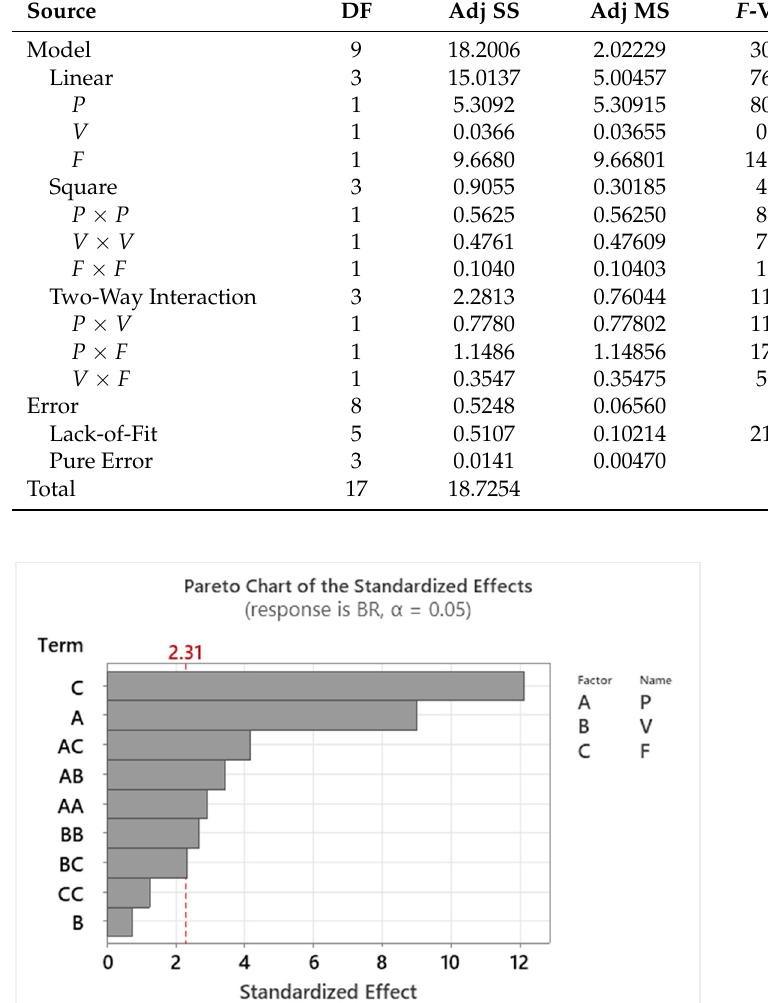
Table 5. ANOVA analysis of BR .